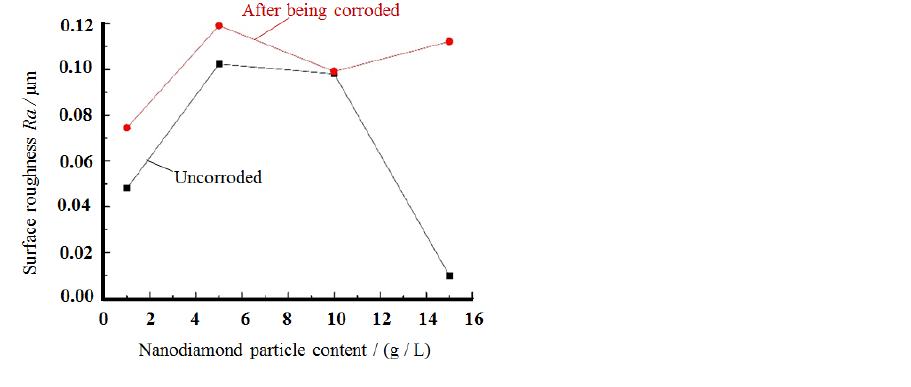
Figure 9. Surface roughness Ra of composite coatings prepared at different diamond concentrations in the plating solution before and after corrosion.